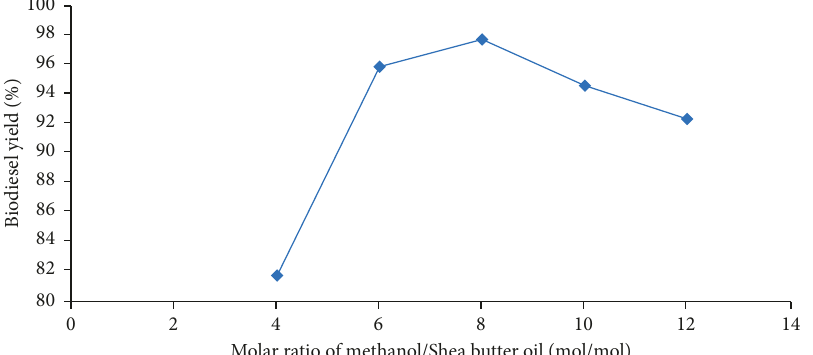
Figure 3: Effect of methanol to oil molar ratio on the FAME yield (reaction time 1.5hrs; catalyst amount 6 wt%; reaction temperature 60 °